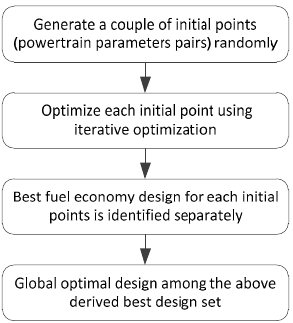
Figure 11. Process of the proposed enhanced iterative optimization. Table 4. Comparison between three approaches proposed in this paper.